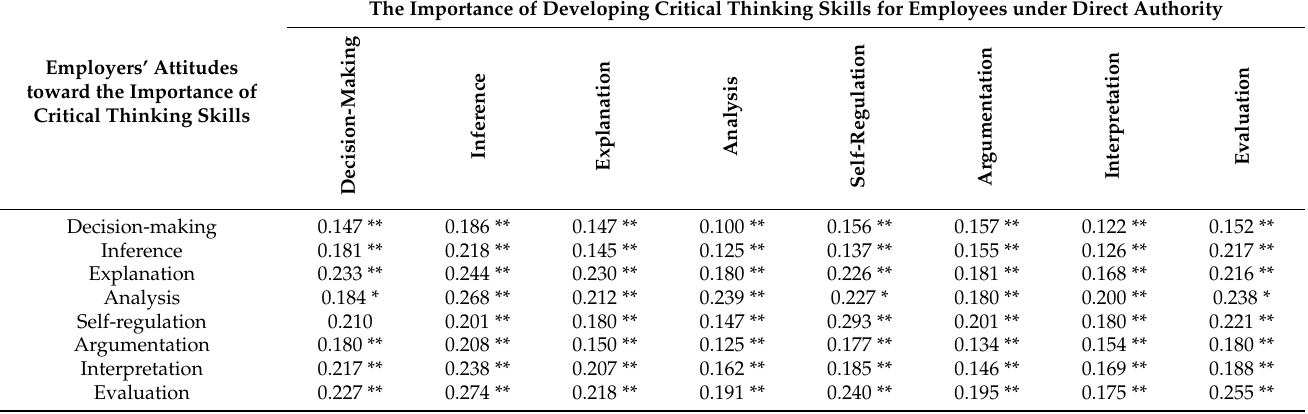
Table 6. Correlation between employers’ attitudes toward the importance of critical thinking skills and the importance of their development for employees under direct authority.